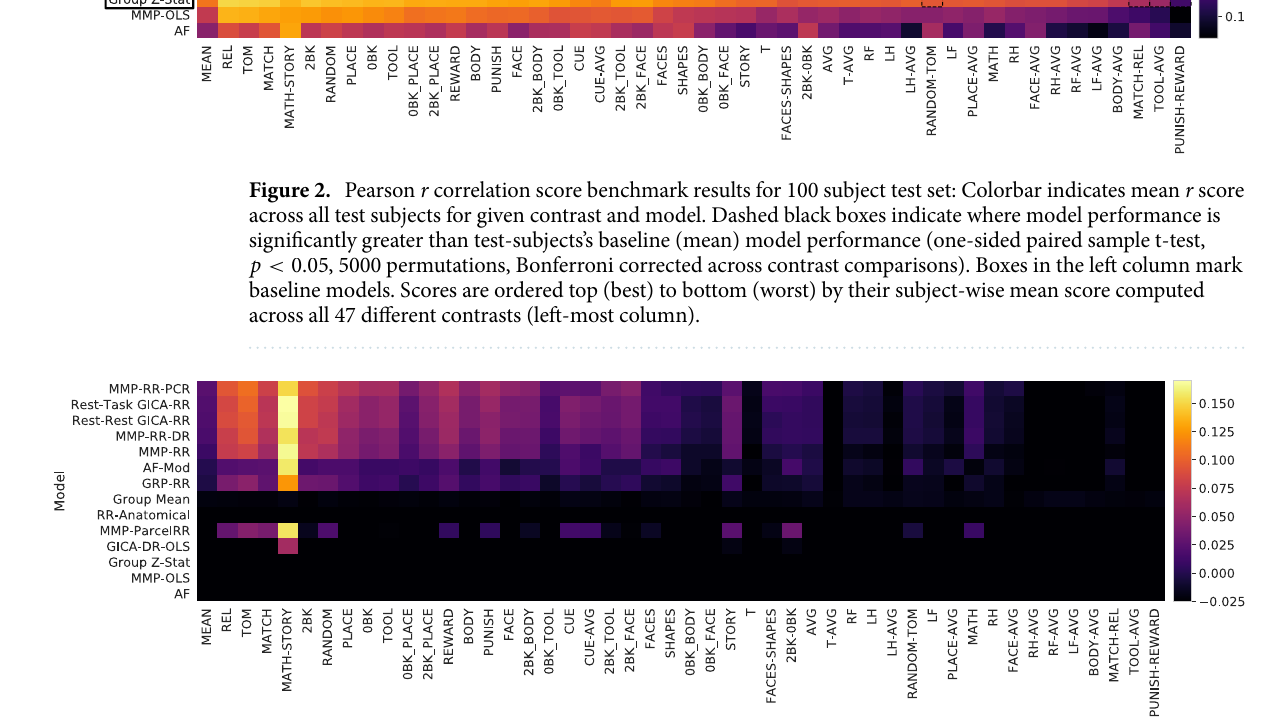
and Fig. S5. Our model MMP-RR-PCR yields both the highest mean performance of subject scores averaged over all con- trast targets ( r = 0.582 ± 0.048 ) with the highest number of significant prediction performance, see Fig. 2. Addi-